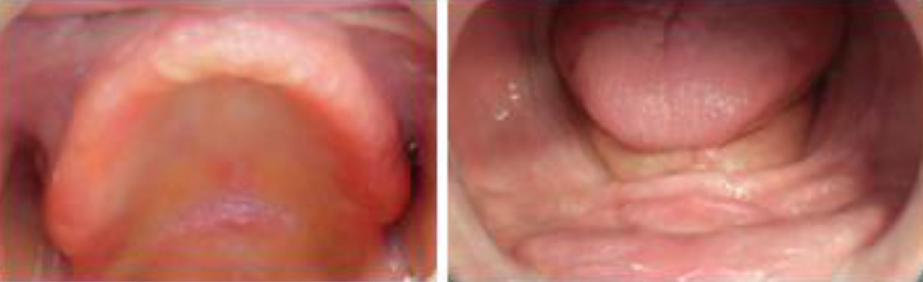
Figure 15: Healthy oral fi bromucosa further to a tissue conditioning treatment.